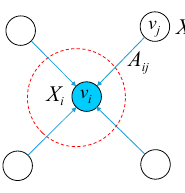
Figure 6. The aggregation of node structural features.